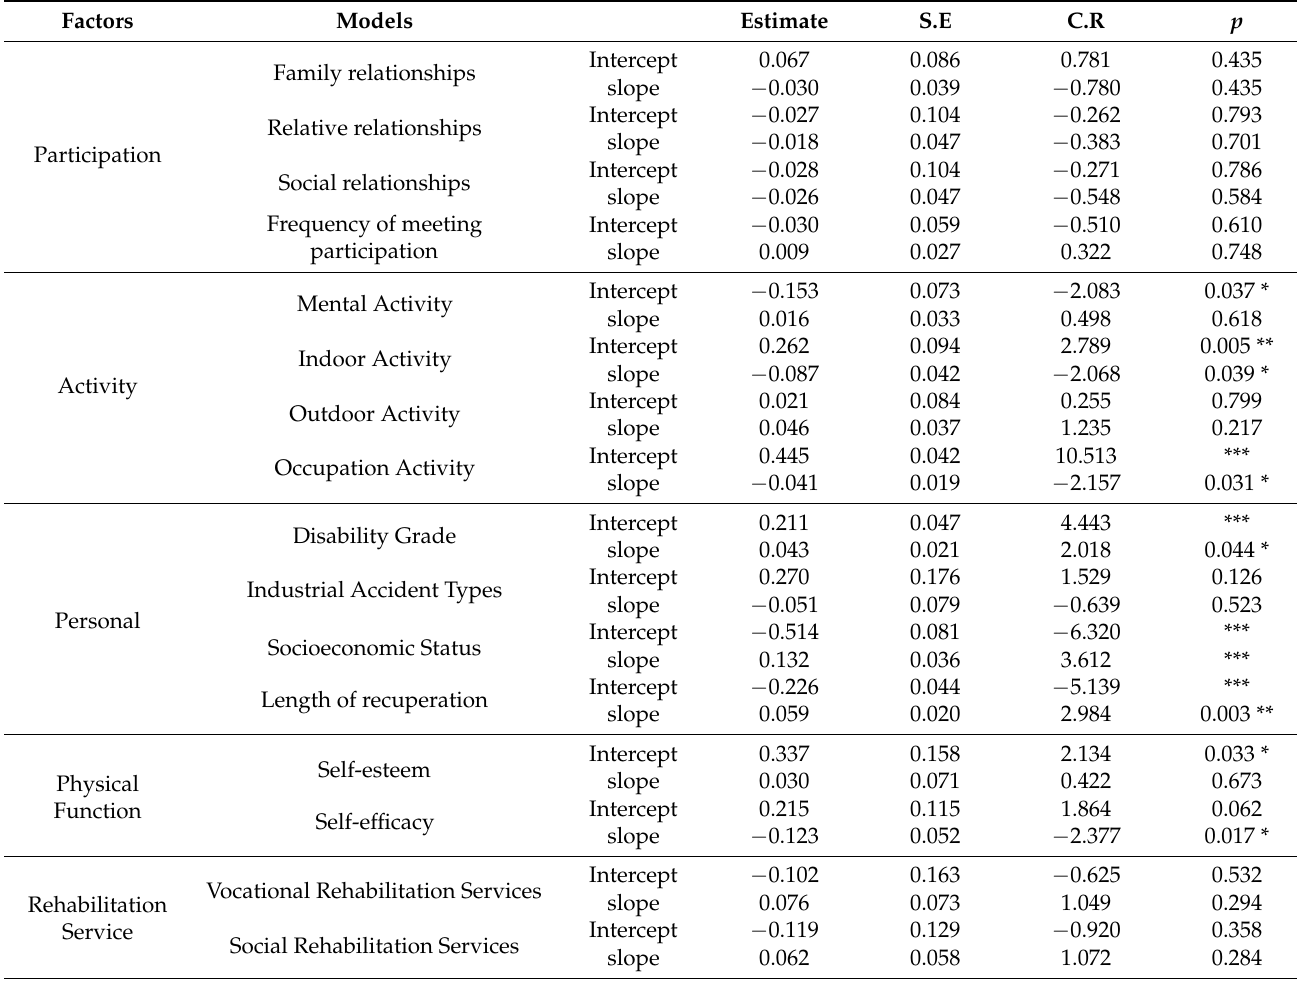
Table 8. Path coefficients of the final